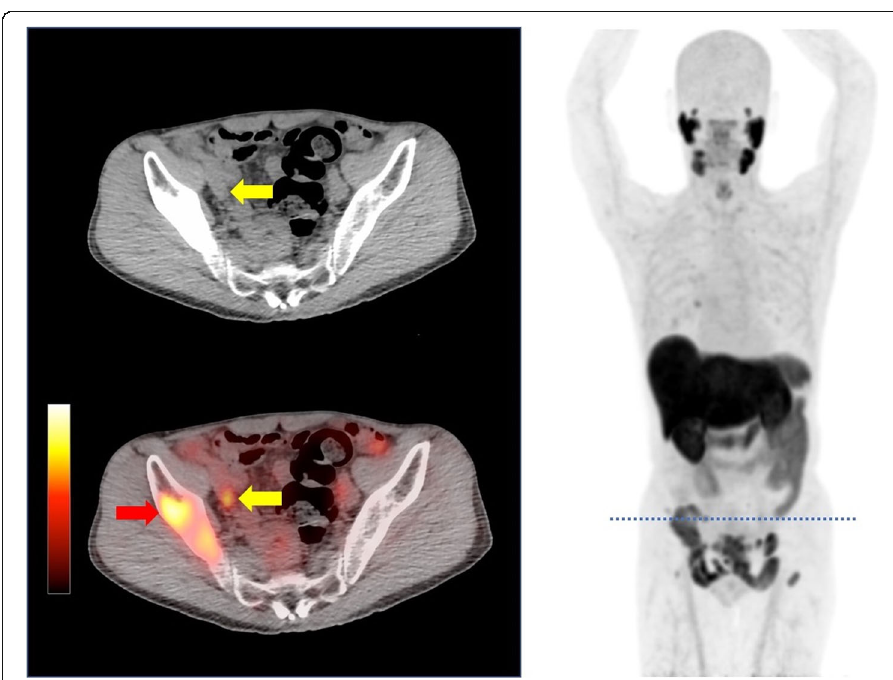
Fig. 8 [ 18 F]PSMA-1007 PET/CT images of a metastatic prostate cancer patient. A dotted cross section of whole-body PET (right) is displayed on the CT and PET/CT image (left). In addition to right iliac metastasis (red arrow), we observed a small lymph node metastatic lesion (yellow arrows), which would be virtually impossible to detect by conventional CT